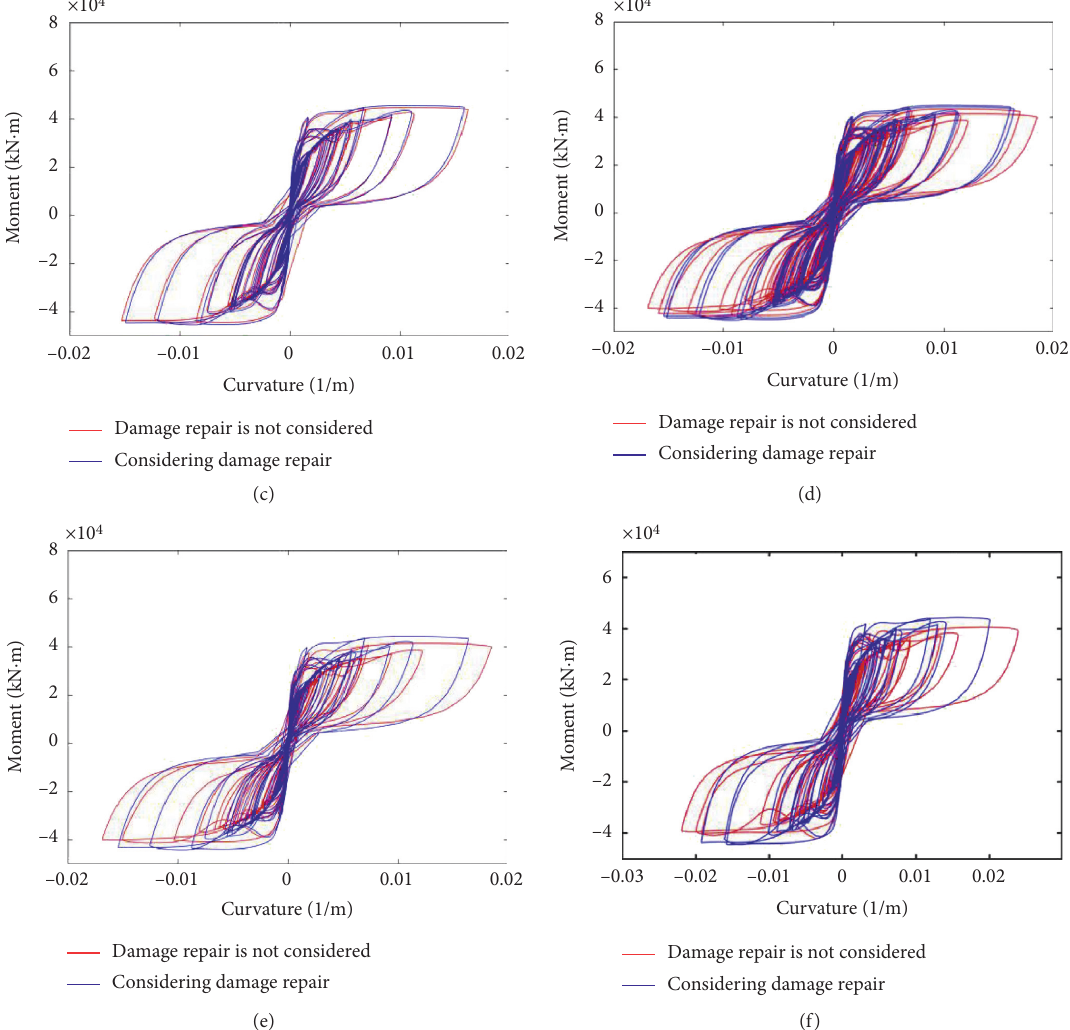
Figure 10: Moment-curvature curves of the Taiwan wave in different service lifes: (a) 0 years; (b) 30 years; (c) 50 years; (d) 70 years; (e) 100 years; (f) 120